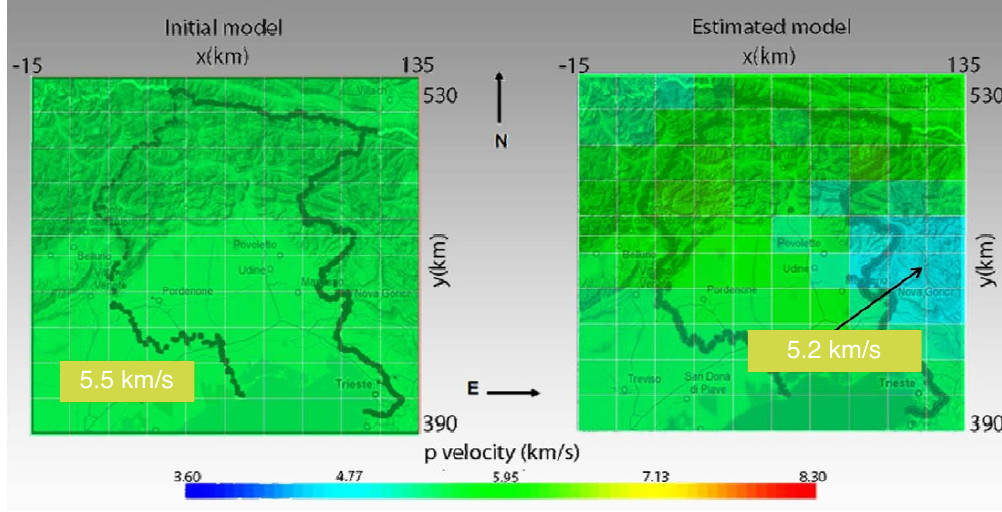
Figure 13. Tomographic inversion of the first layer in the model in Figure 2. Homogeneous initial model (left) and estimated P velocities (right).